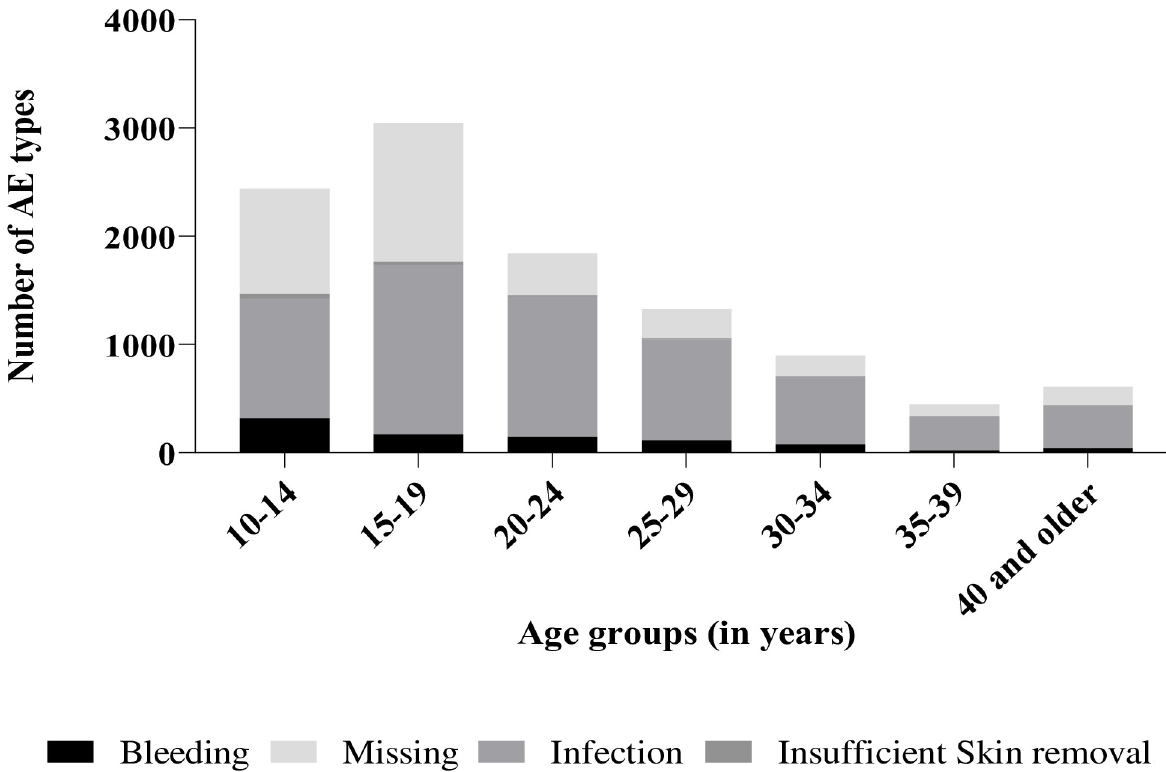
Fig 3. Number of AEs identified by type per age